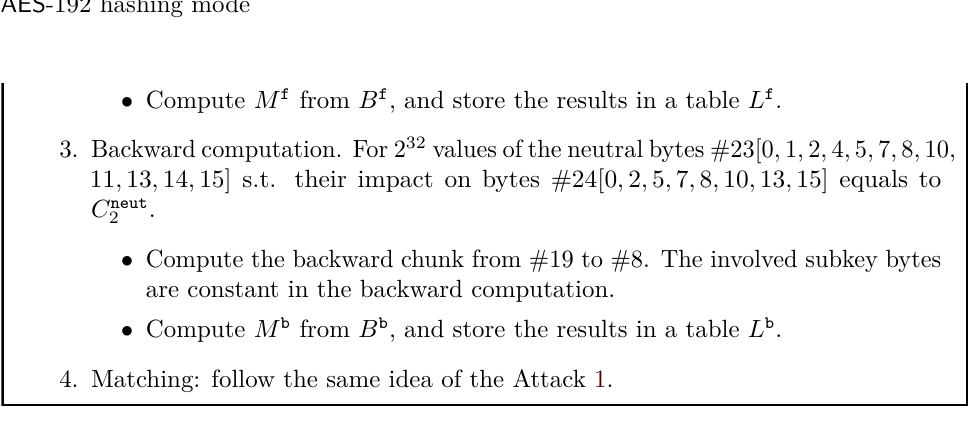
Figure 12: Introducing free bytes in the key to launch an 8-round preimage attack on AES -192 hashing